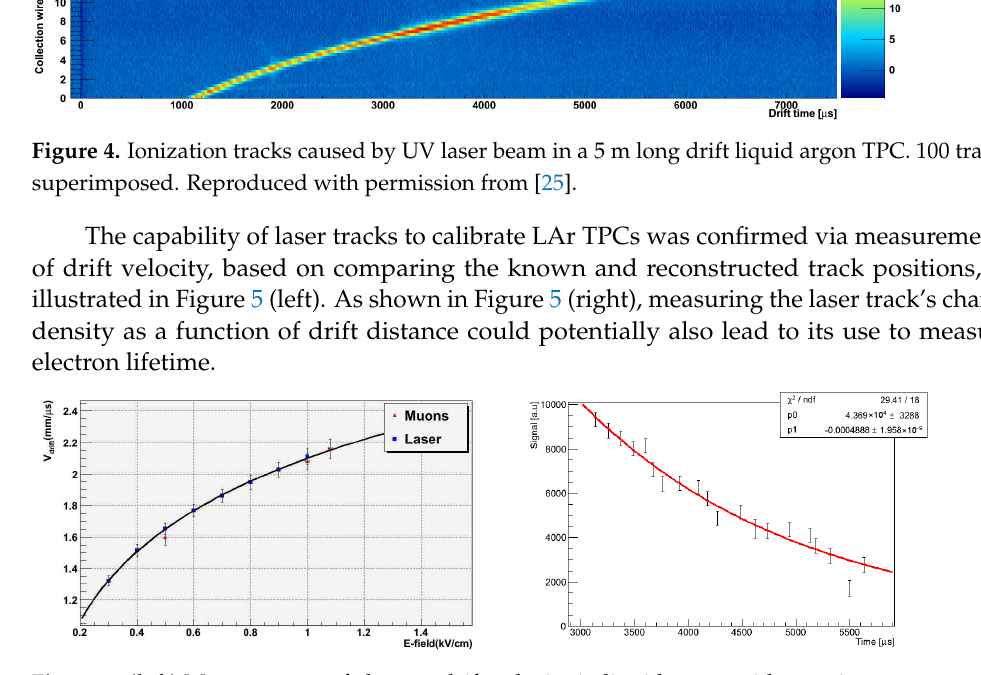
Figure 5. ( left ) Measurement of electron drift velocity in liquid argon with cosmic ray muons and UV laser. Reproduced with permission from [23]. ( right ) Measurement of electron charge attenuation in liquid argon with UV laser beams. Reproduced with permission from